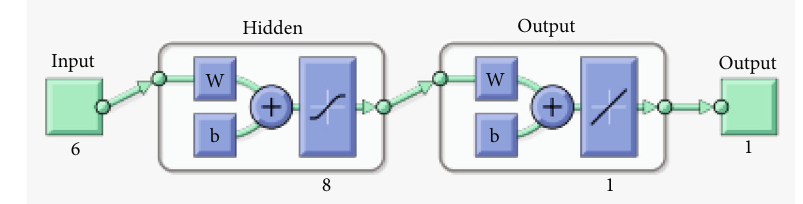
Figure 9: The proposed neural network